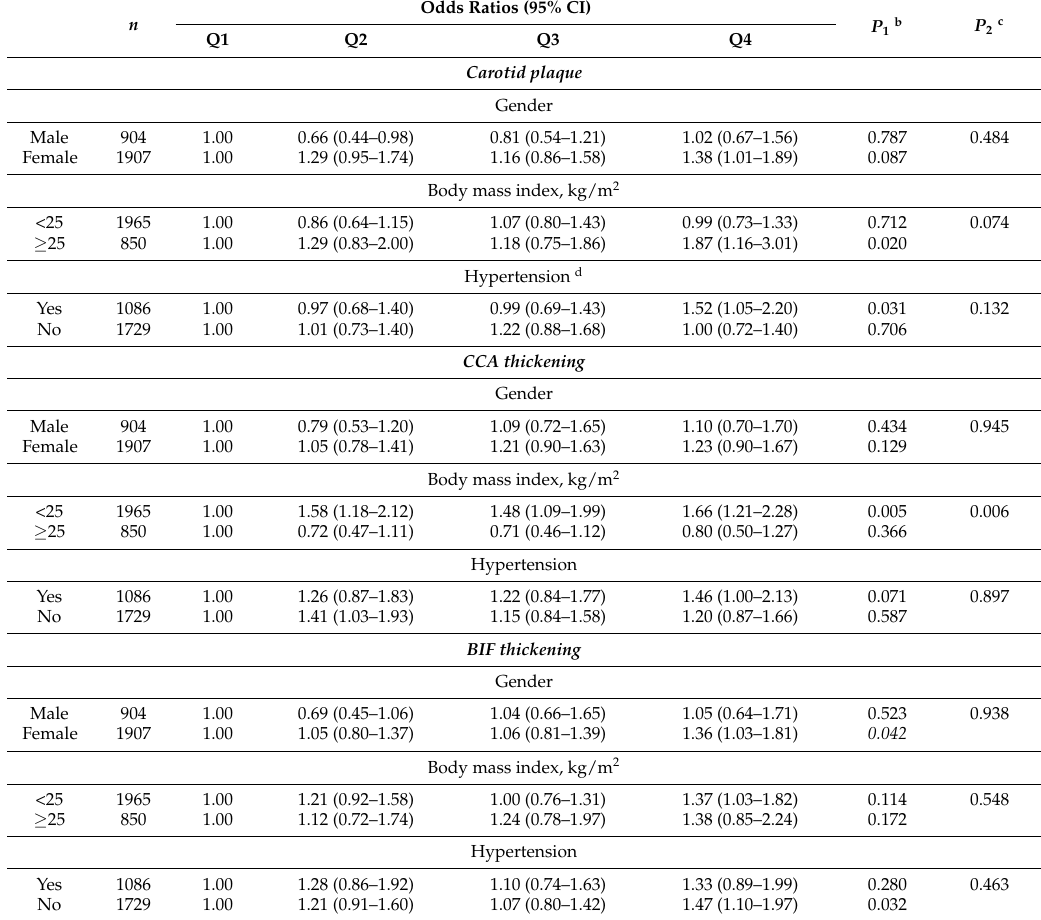
Table 4. Multivariate-adjusted odds ratios (95% CI) for carotid intima-media thickening by quartiles (Q) of urinary sodium/creatinine ratio stratified by gender, body mass index and hypertension status a